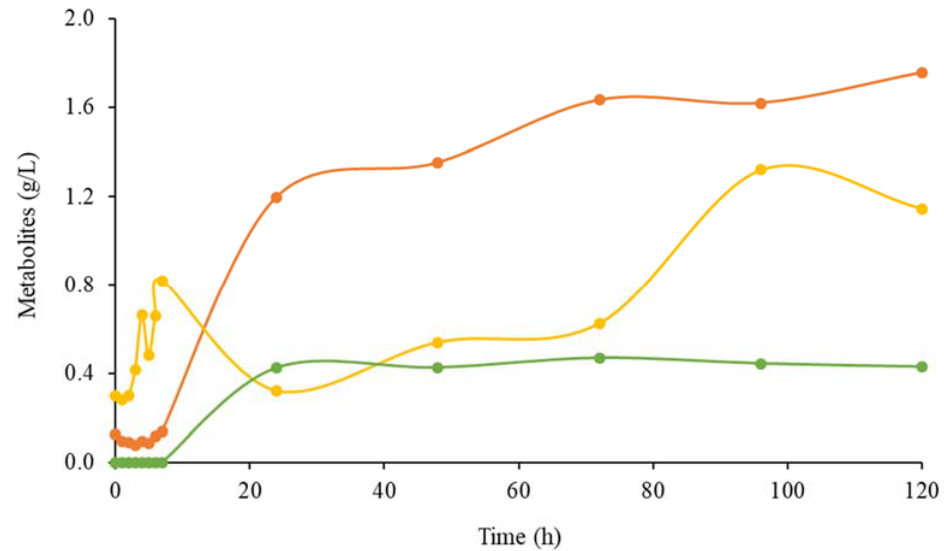
Figure 6. Acetic acid (yellow), ethanol (orange), and butanol (green) production during Clostridium carboxidivorans syngas fermentation in ATCC®2713 with 0.15% ( v/v ) Tween®80 in bioreactor. The maximum ethanol concentration obtained in STBR after 120 h in ATCC®2713 medium with 0.15% Tween®80 was 1.76 g/L. Although biomass production in ATCC®2713 with 0.15% Tween®80 in the bioreactor was much higher (140%) than the obtained in